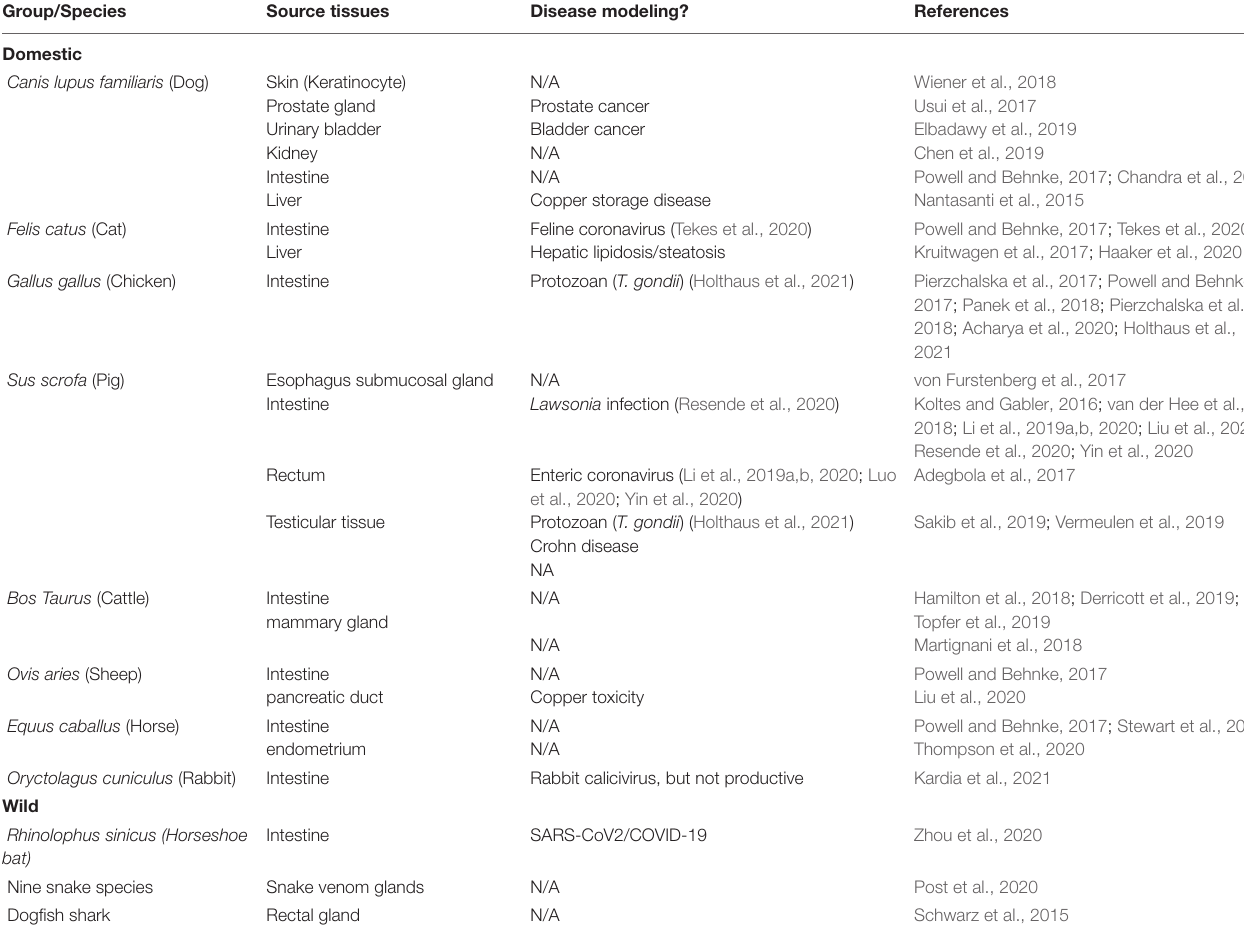
TABLE 2 | Organoid cultures validated in domestic and wild animal species (Bourdon et al., 2021; Kar et al., 2021; Pain, 2021).